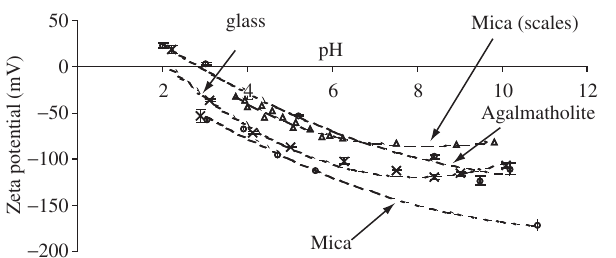
Figure 4. Zeta potential of disks of mica, glass and